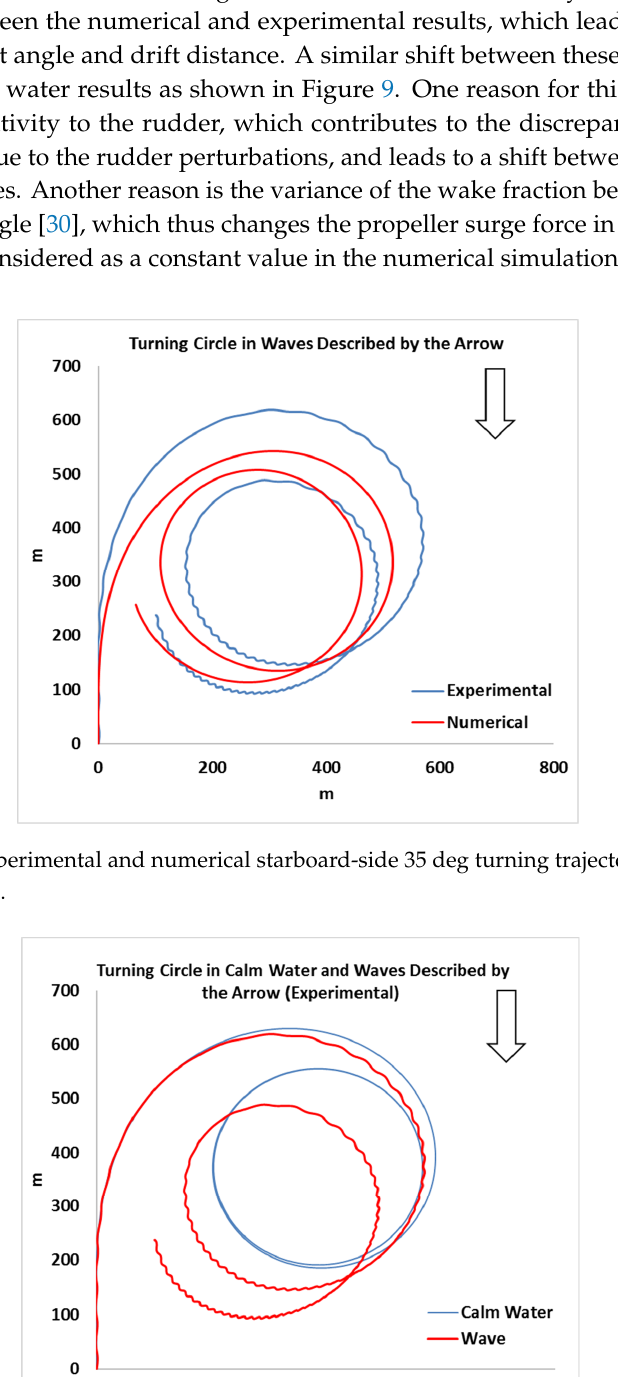
Figure 10. Parameters of the turning trajectory in waves: ( a ) Drift angle and drift distance; ( b ) Horizontal and vertical diameter of the turning trajectory.